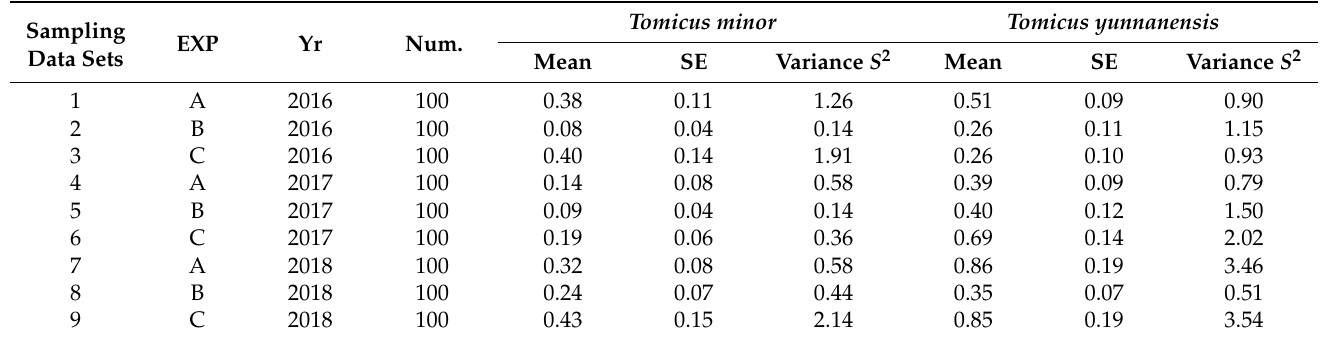
Table 1. Sampling of Tomicus minor and Tomicus yunnanensis infested on Pinus yunnanensis from different experimental sites during the late shoot-feeding phase from 2016 to 2018.